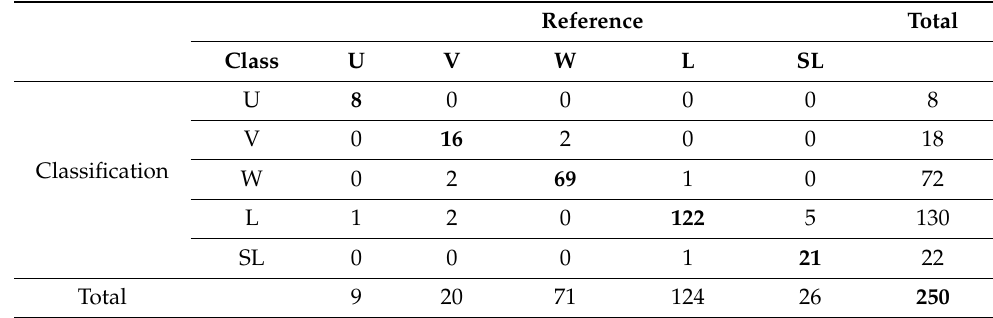
Table 2. Error matrix of the classification outcomes. The diagonal results, indicated as bold, represent the number of points for which the predicted label is equal to the true label, while off-diagonal results are those that are mislabeled by the classifier.